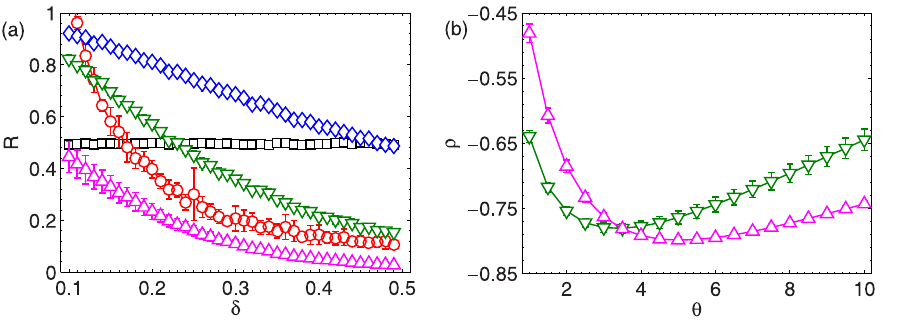
Figure 1. (a) The relation between S R c T and d c in different methods. The parameters are set as h ~ 3 in IARR and h ~ 5 in IARR2. (b) the dependence of the Pearson correlation r on h in IARR and IARR2 methods. The results in this figures are averaged over 10 independent realizations. The error bars are the corresponding standard deviations.